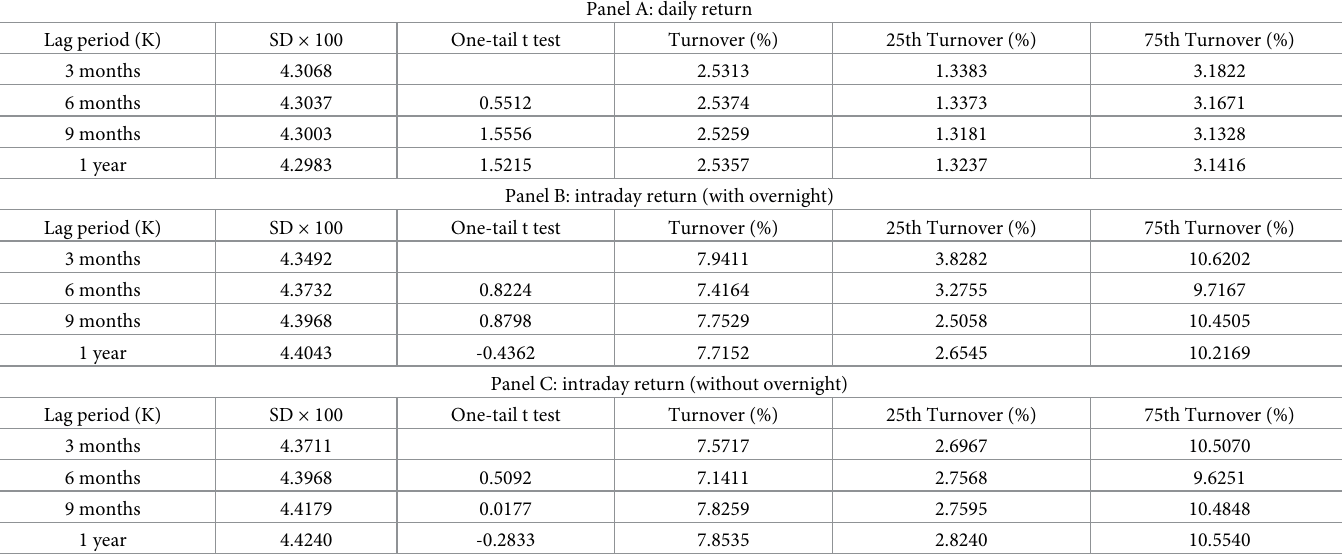
Table 7. Out-of-sample performances of FACTOR-MIDAS-POET method (T = 1